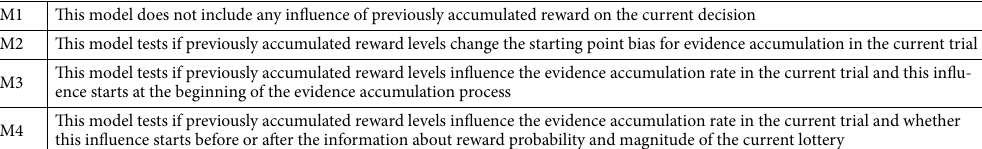
Table 1. Summary of four starting time drift diffusion models.